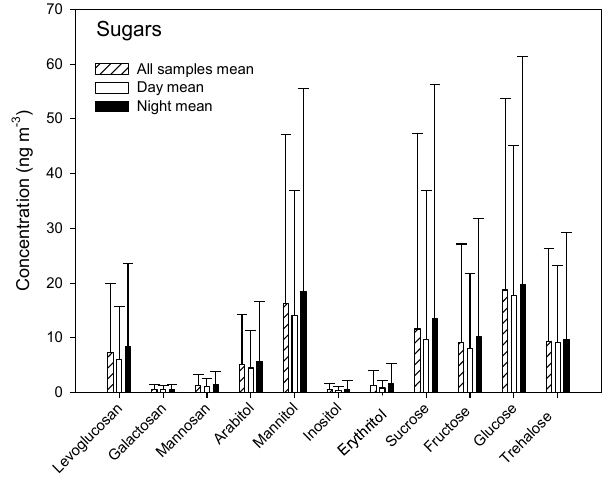
Figure 3. Average concentrations of sugars detected in marine aerosols over the East China